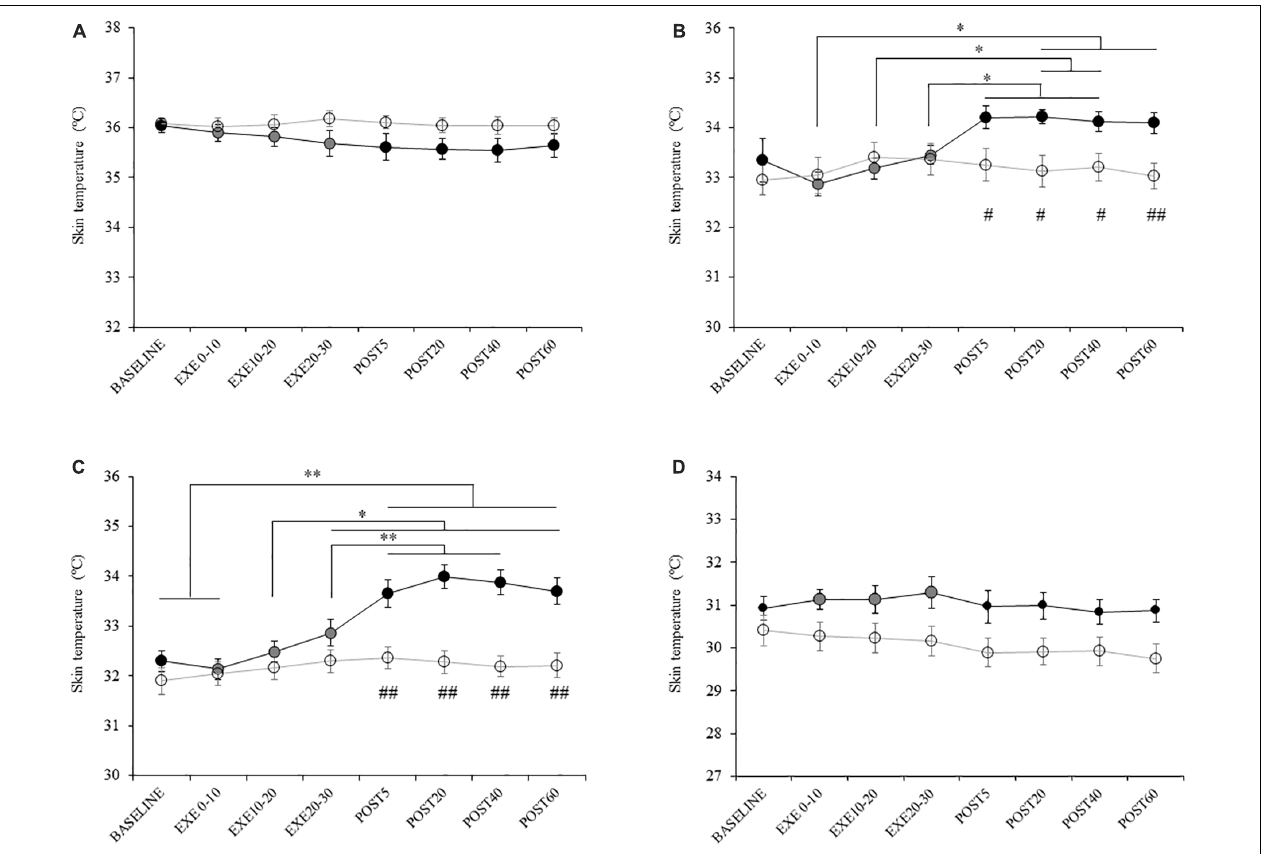
FIGURE 5 | Changes in skin temperature. Filled and open circles indicate exercise and control conditions, respectively. Temperature of the (A) axilla, (B) first dorsal interosseous, (C) thigh, and (D) lower leg. ∗ p < 0.05 compared with baseline, ∗∗ p < 0.01 compared with baseline, # p < 0.05 compared with control condition. ## p < 0.01 compared with control